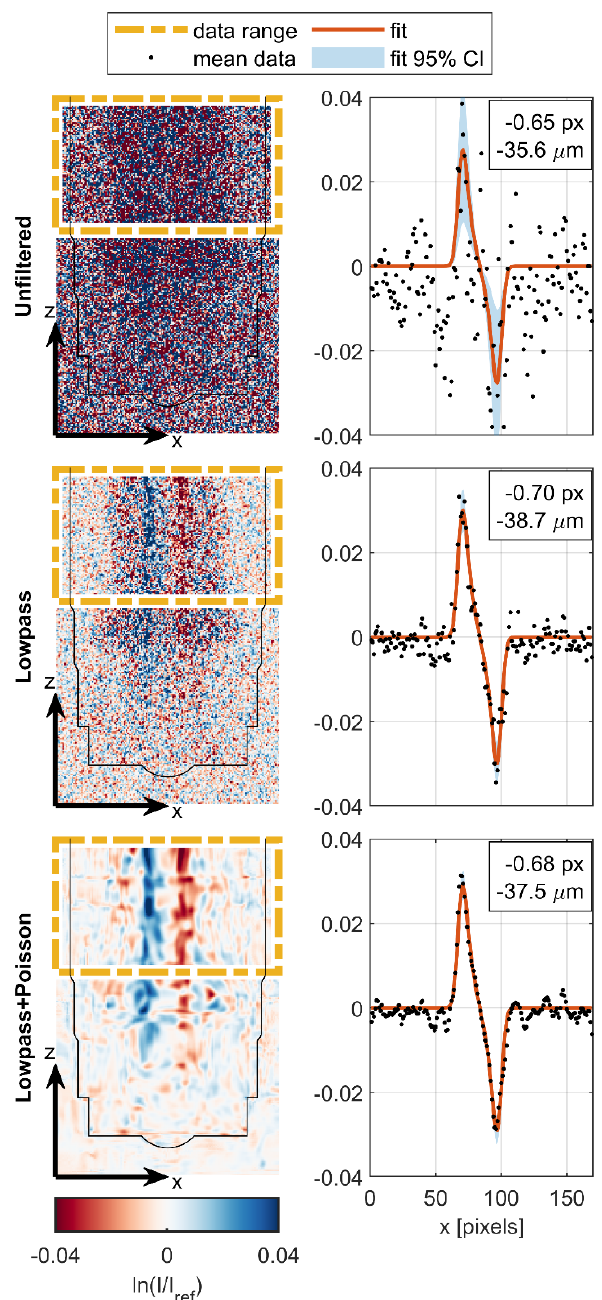
Figure 8. Examples of attenuation model fitting for each filtering level. Log-ratio normalized images are from a time bin with a relatively large needle displacement ( t = 2.27 ms), and the injector body outline has been overlaid on the normalized images for clarity. Negative (red) in images corresponds to a decrease in neutron count rate relative to the reference, whereas positive (blue) indicates an increase. The blue and red vertical bands indicate the cylindrical needle moving to the left, because the steel needle has a lower attenuation coefficient than the surrounding hydrogenous fuel.